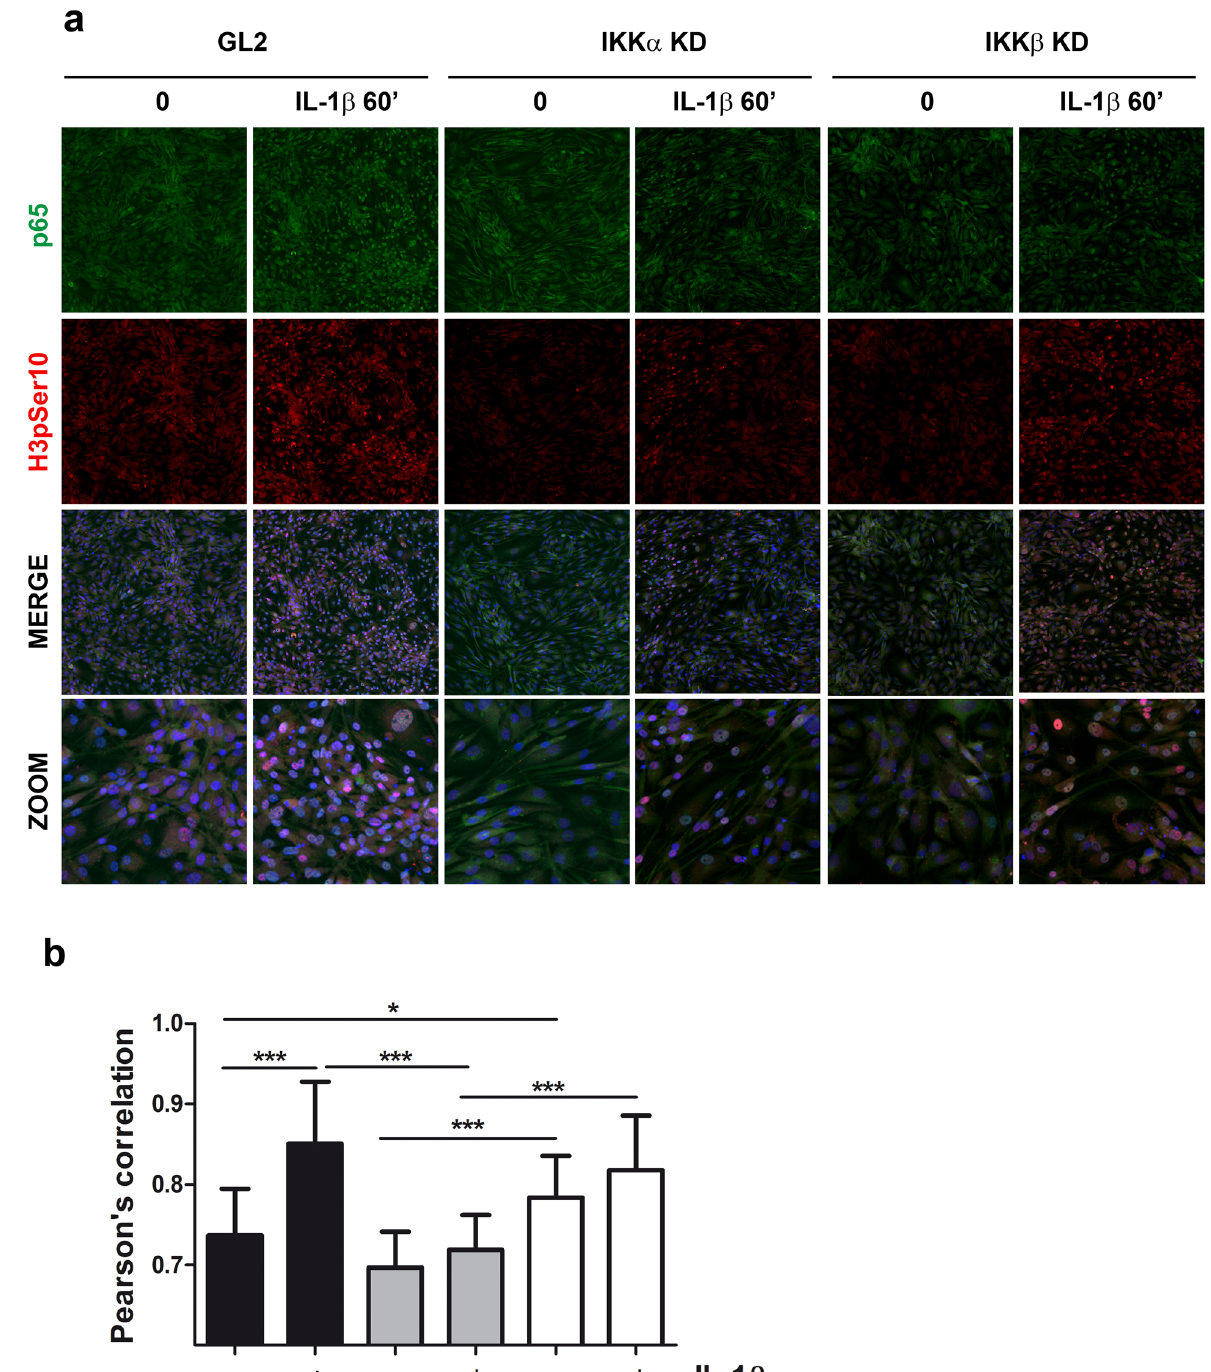
Figure 5. IKK dependency of co-localized p65 and H3pSer10. ( a ) Confocal analysis of the extent of co-localization of p65 signal (green) with that corresponding to the phosphorylated Serine 10 of the histone H3 (red) in both basal conditions and after 60 min stimulation with 2 ng/ml IL-1β. The distinct signals are shown, together with the merged images including Hoechst 33342 as a nuclear counterstaining and a ×3 zoom in order to better appreciate the co-localized signal at the nuclear level, appearing as pink dots. ( b ) Analysis of the extent of co-localization derived from 26 different images for each condition, spread in the whole samples. Data are reported as mean ± SD. The means of the groups were compared by ANOVA, followed by Tukey’s post hoc test. The differences were considered significant when p < 0.05 with *p < 0.05; **p < 0.01; and ***p < 0.001. In both IKK KD, the IL-1β dependent induction is greatly blunted compared to the IKK proficient GL2 chondrocytes. Noteworthy, co-localized signals were significantly lower in IKKαKD compared to IKKβKD in both basal conditions and after IL-1β stimulation. IKKαKD data after IL-1β were significantly lower compared to both GL2 and IKKβKD